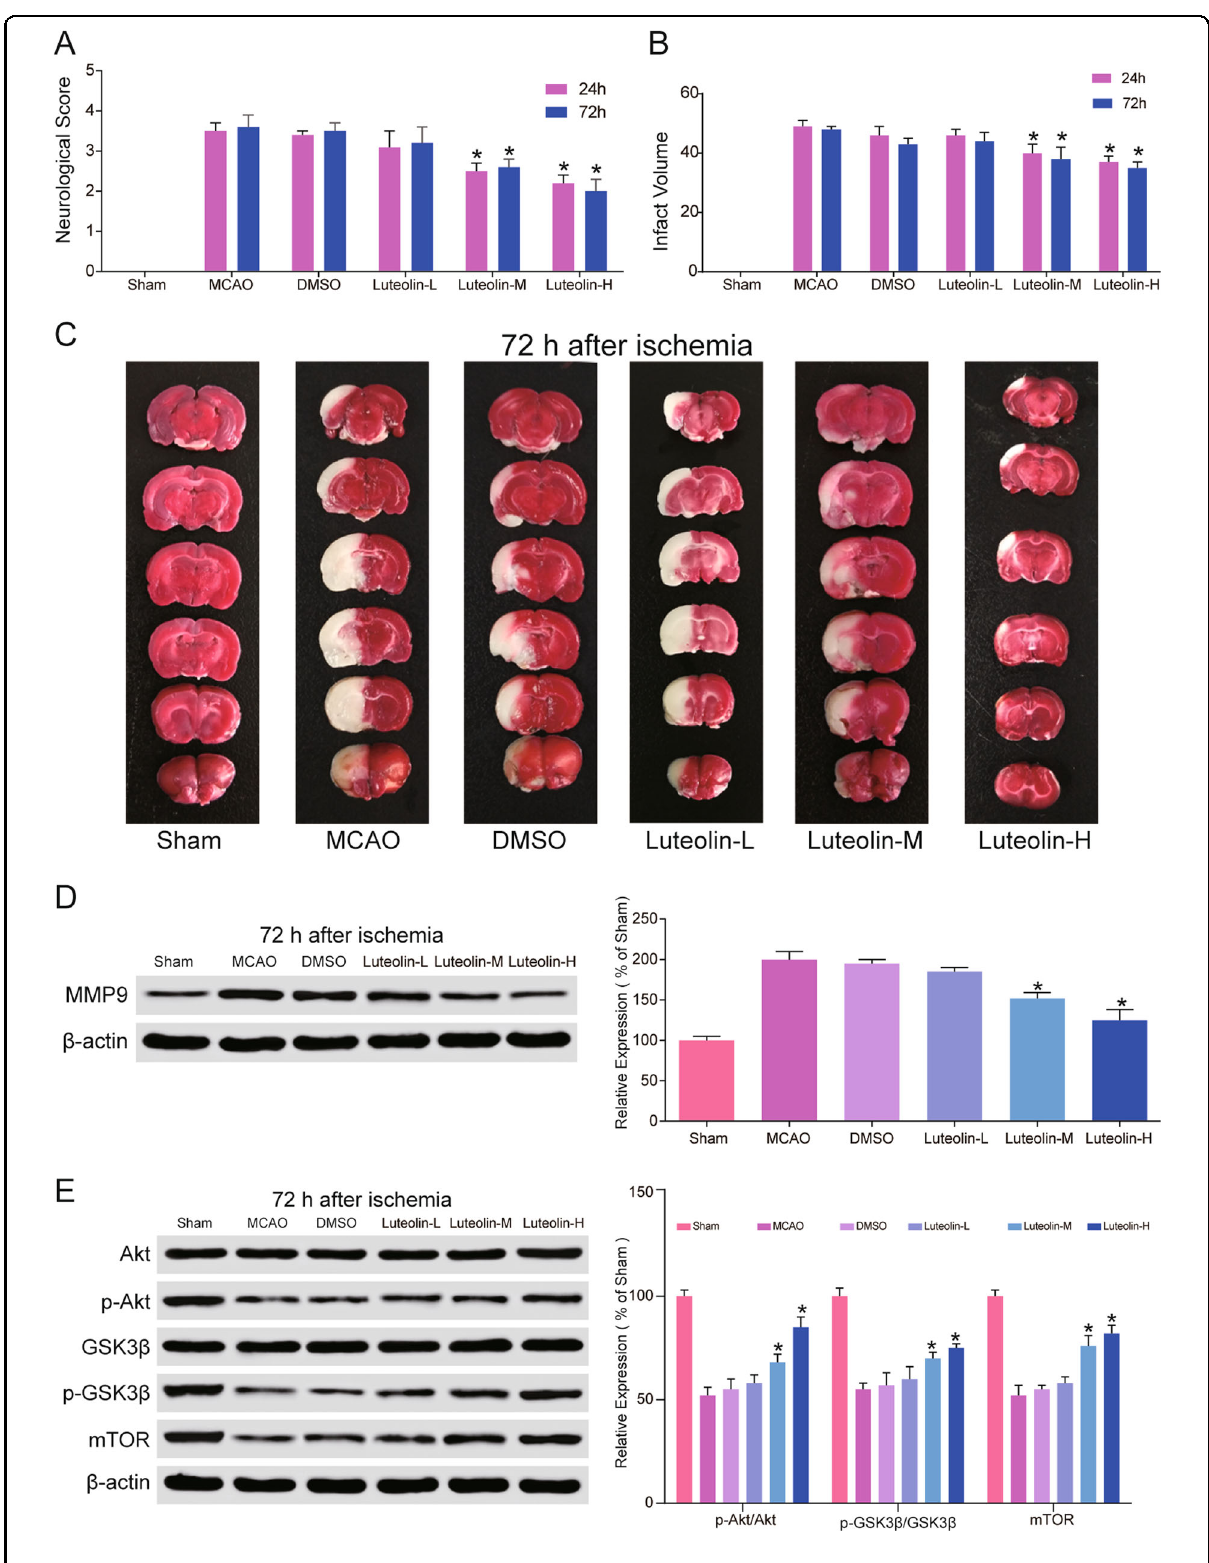
Fig. 4 (See legend on next